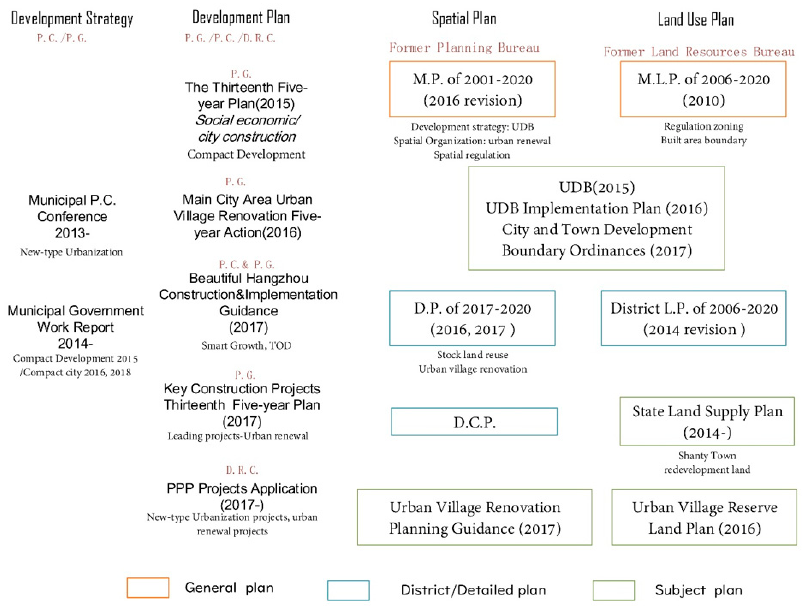
Figure 1. The NTU planning system in Hangzhou. (P.C.: Municipal CPC Party Committee; P.G.: Municipal people’s government; D.R.C.: Development Reform Committee; M.P.: Master Plan; D.P.: District Plan; M.L.P.: Master Land use Plan; UDB: Urban Development Boundary; D.C.P.: Detailed Control Plan).